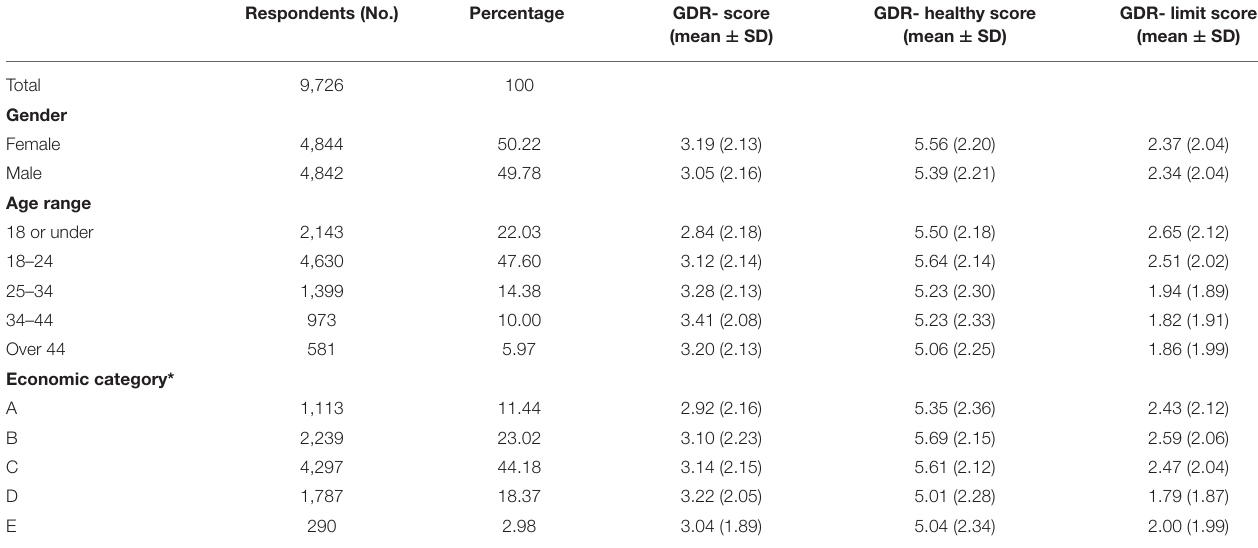
TABLE 3 | Summary of respondents by group.